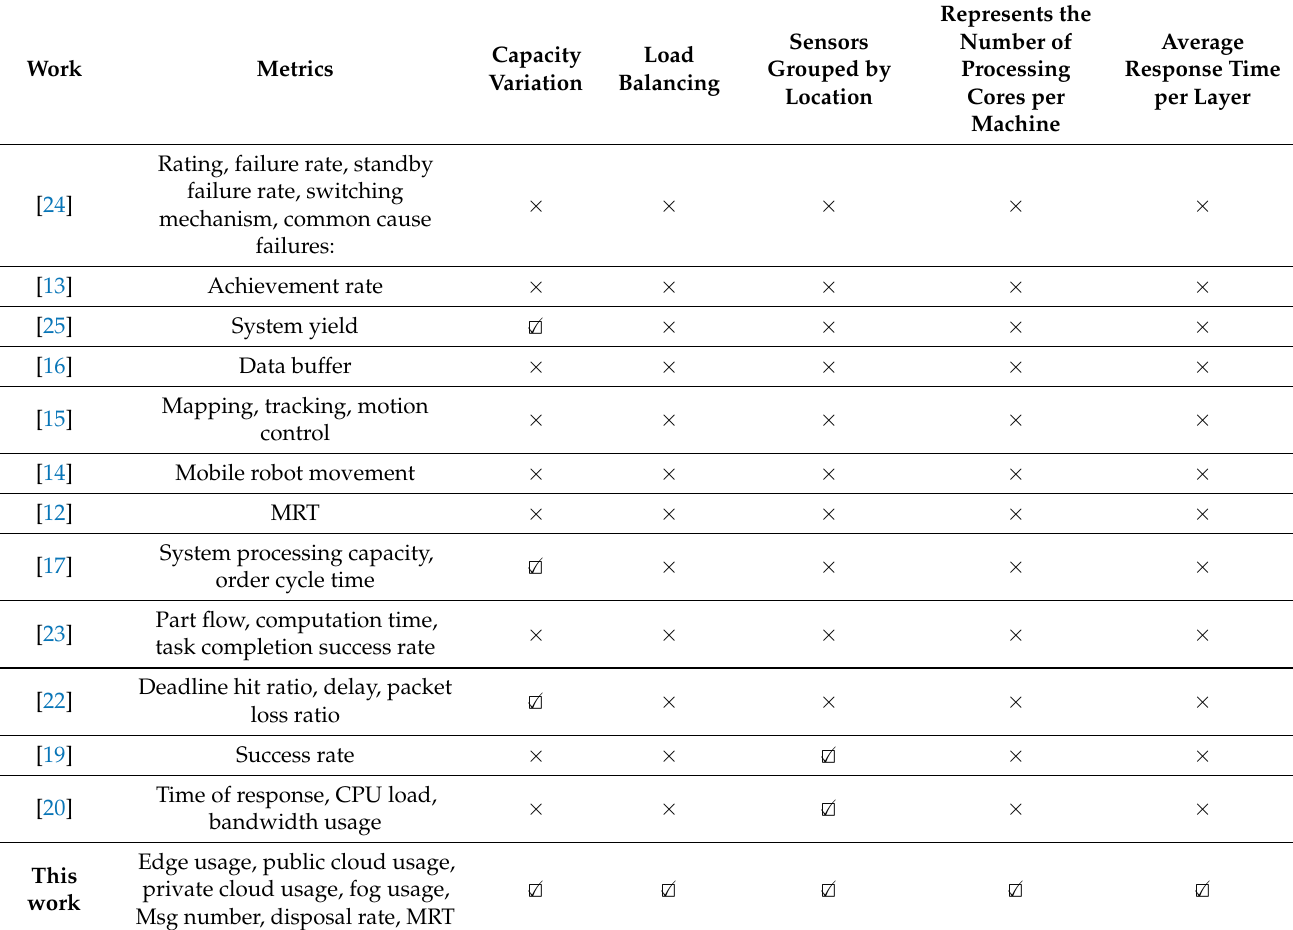
Table 1. A comparison of the related